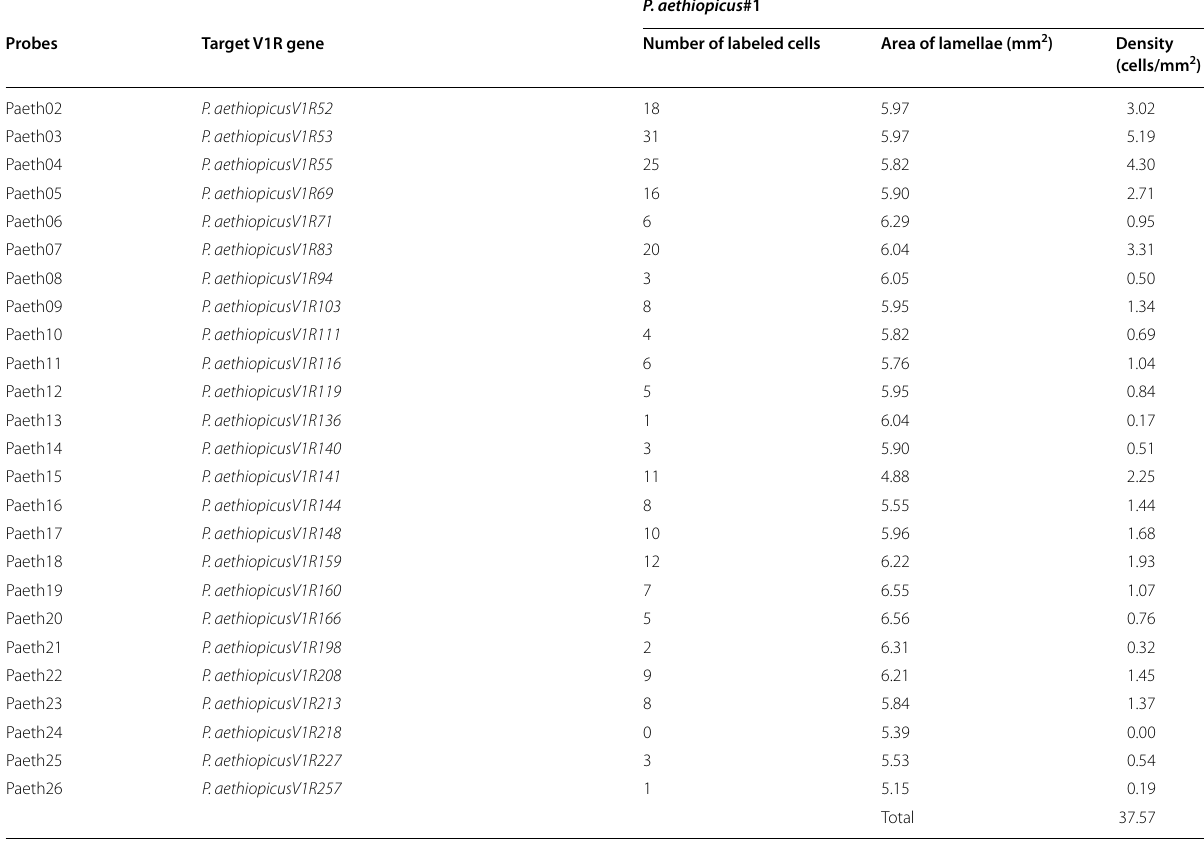
Table 4 Density of cells labeled by single probes for V1Rs in the lamellae of P. aethiopicus